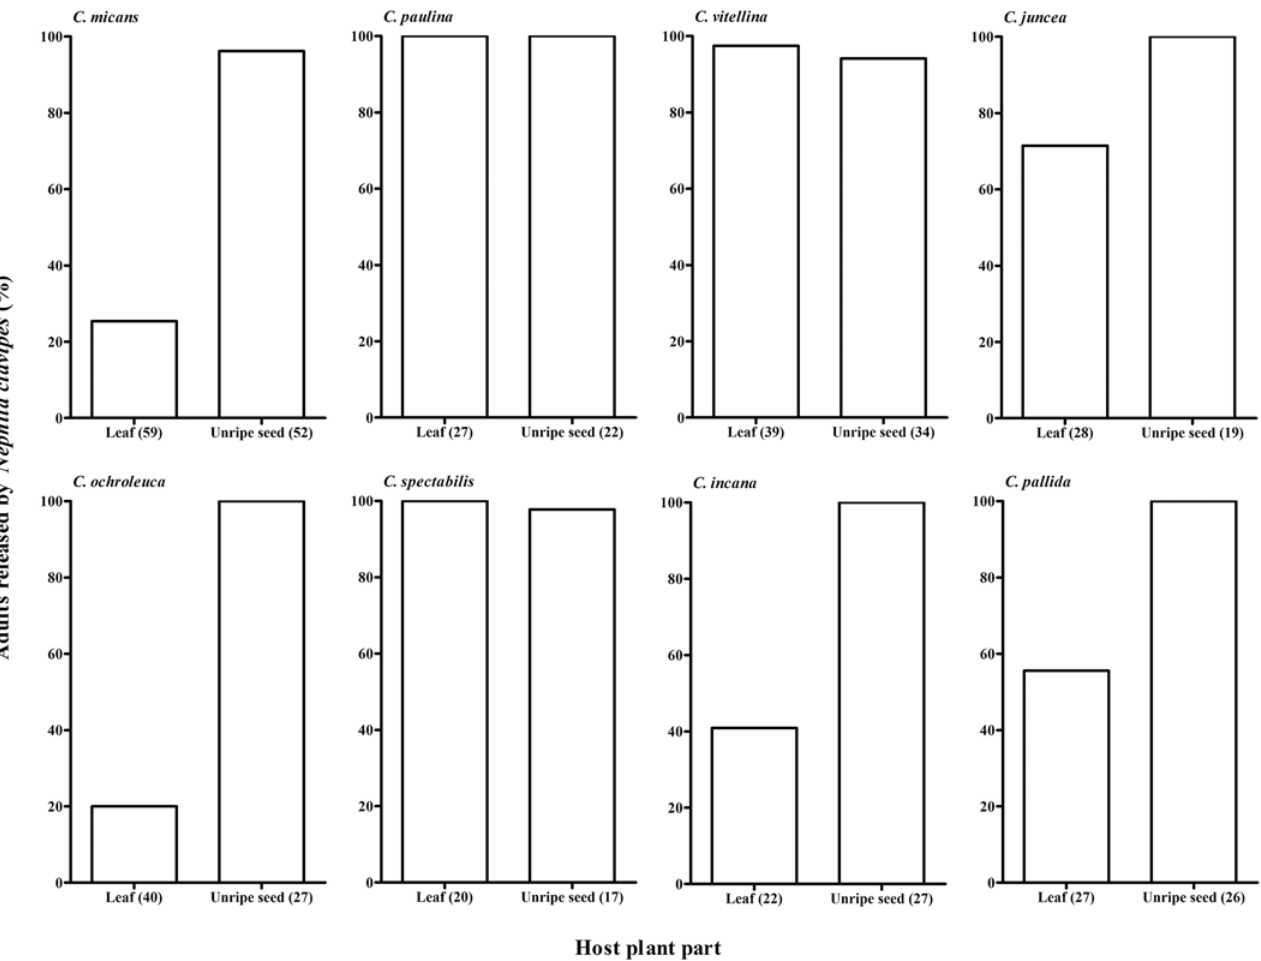
Fig 3. Percentage of adults of Utetheisa ornatrix released by Nephila clavipes with respect to eight host-plant species and plant parts (leaf or unripe seed) fed to the larvae. The natives Crotalaria micans , C . paulina , and C . vitellina , non-natives C . juncea , C . ochroleuca , and C . spectabilis , and species of uncertain origin C . incana and C . pallida . Numbers in parentheses in "plant part" represent the number of adults bioassayed for each diet.